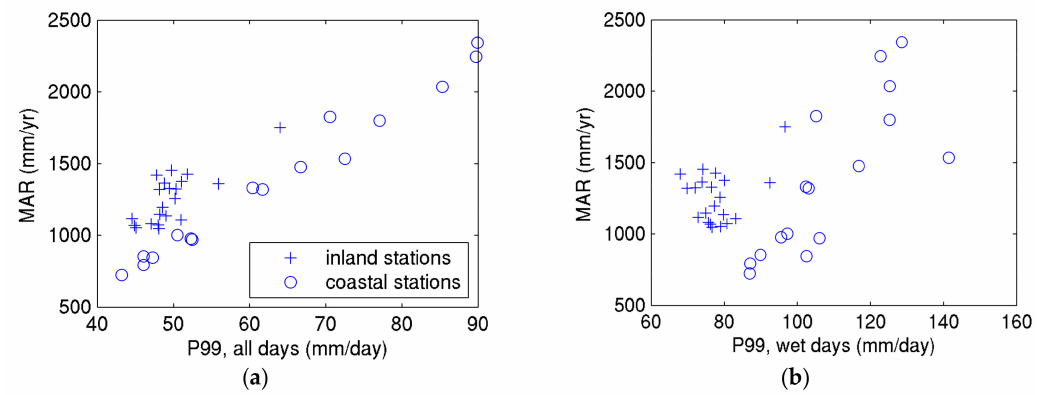
Figure 3. Mean annual precipitation and 99th percentile of daily precipitation at the 38 stations (observed data, 1951–2015): ( a ) all days; ( b ) wet days